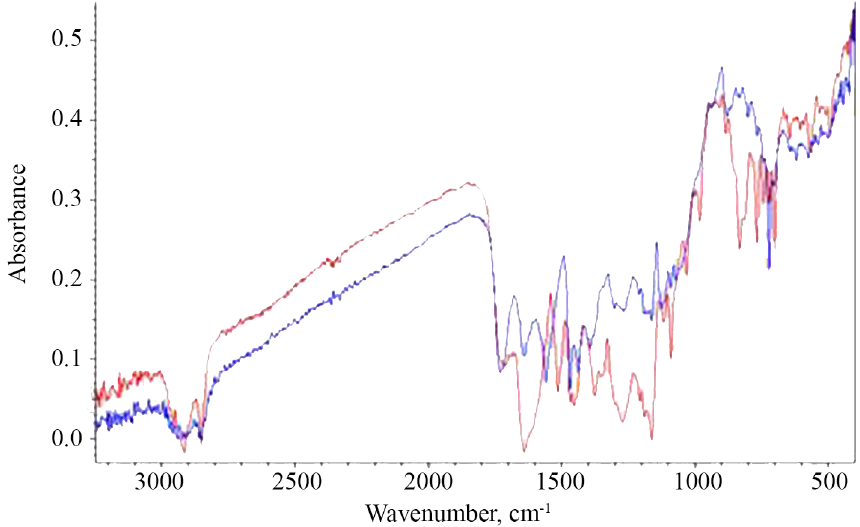
Fig. 5. IR spectrum of